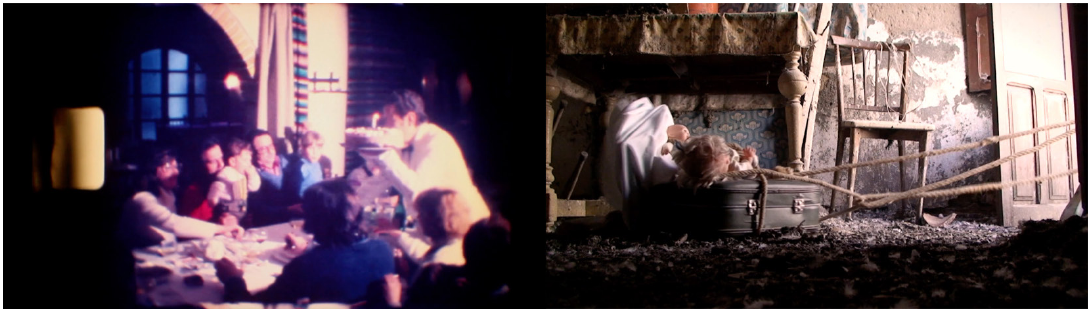
Figure 4. Two still images from Domingo Martínez, At Home , Spain 2017 (translation of “En casa,” Silvia Terrón’s translation from the French translation of Deryn Rees-Jones’ poem